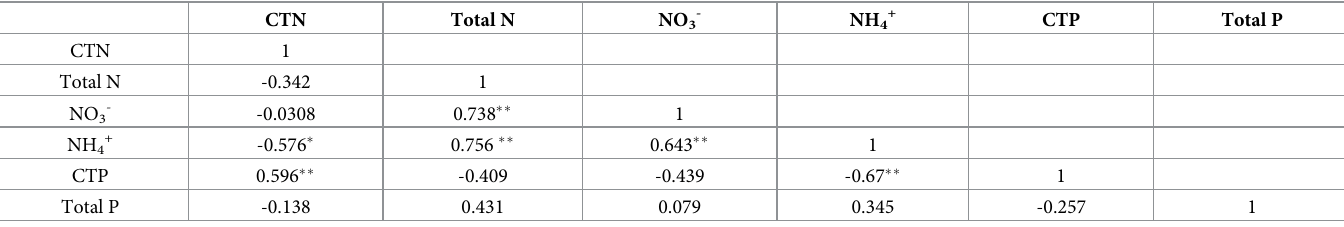
Table 4. The correlations between the total nitrogen, total phosphorus absorption by cotton and loss of nitrogen and phosphorus in leaching water (kg hm -2 ).